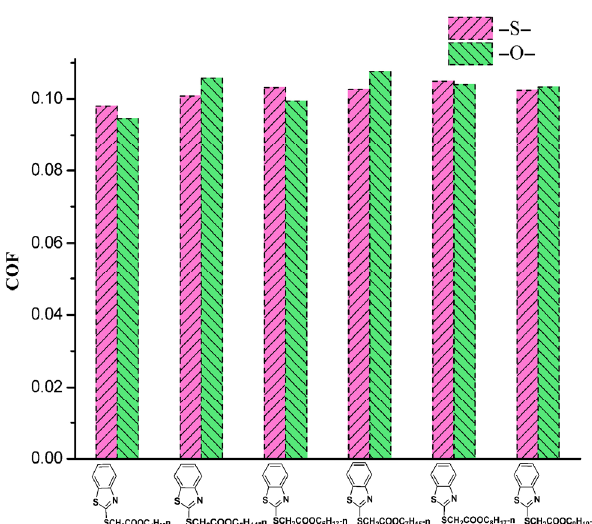
Fig. 24 The friction coefficient when lubricating with 2- benzothiazole-S-carboxylic acid esters and their isosteres in triisodecyl trimellitate.